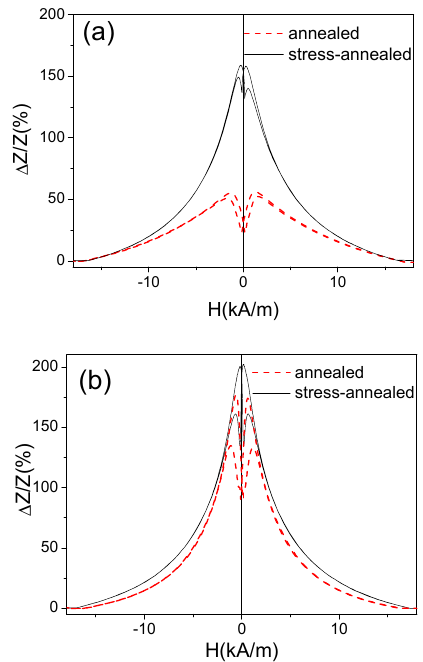
Figure 7. Comparison of ∆ Z / Z(H) dependencies of annealed and stress-annealed ( σ = 354 MPa) at T ann = 200 °C ( a ) and T ann = 350 °C samples ( b ) measured at 200 MHz.